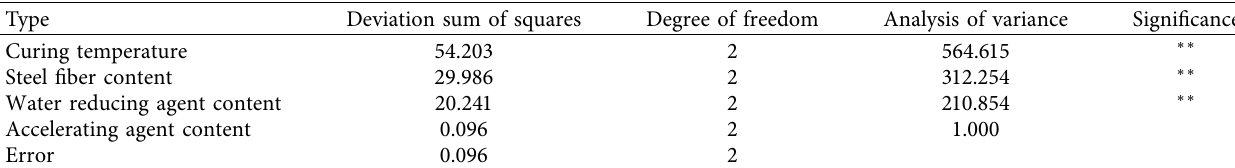
Table 11: Table of variance analysis of compressive strength of 28-day-old concrete